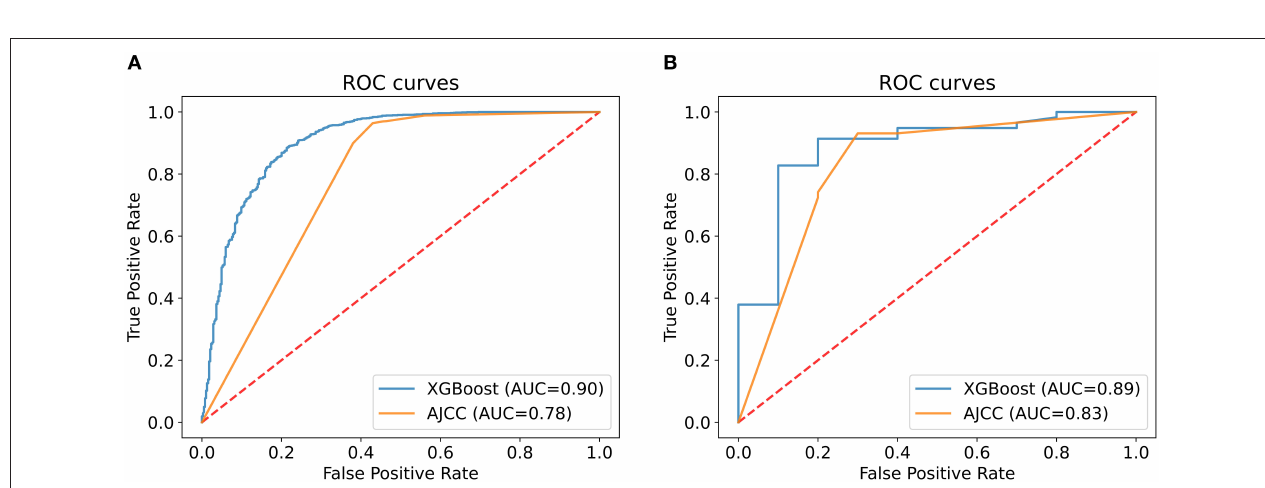
FIGURE 4 | Comparison of the XGBoost model and the AJCC seventh staging system. The area under the curve (AUC) of the XGBoost model to predict 5-year survival status was larger than that of the AJCC seventh staging system in both internal (A) and external validation (B) .